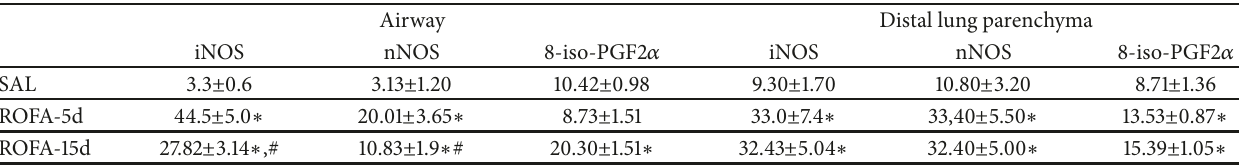
Table 3: ROFA-induced oxidative stress : after both five (ROFA-5d) and fifteen instillations (ROFA-15d), mice presented an increase in the numberof neutrophils and inflammatory cells that express nNOS and iNOS around airways and in distal lung parenchyma. The macrophages were significantly increased only in ROFA-15d groups compared to saline. ∗ P < 0.05 compared to saline; #P < 0.05 compared to